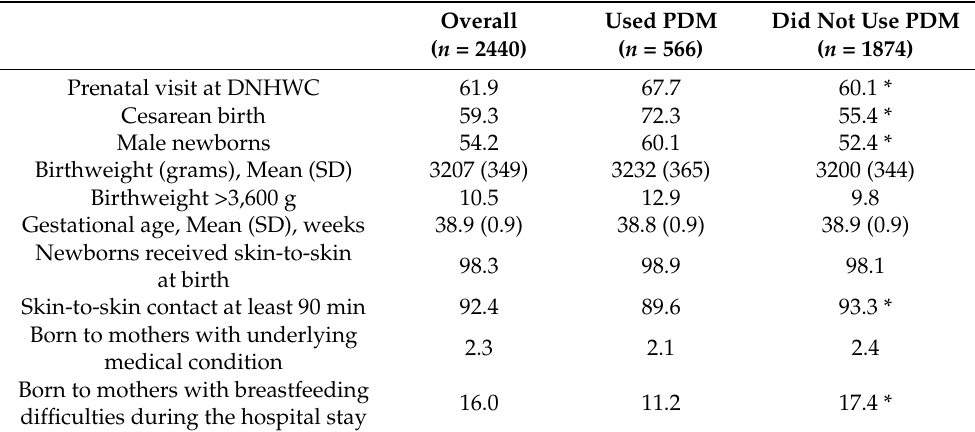
Table 2. Newborn characteristics by pasteurized donor milk use.